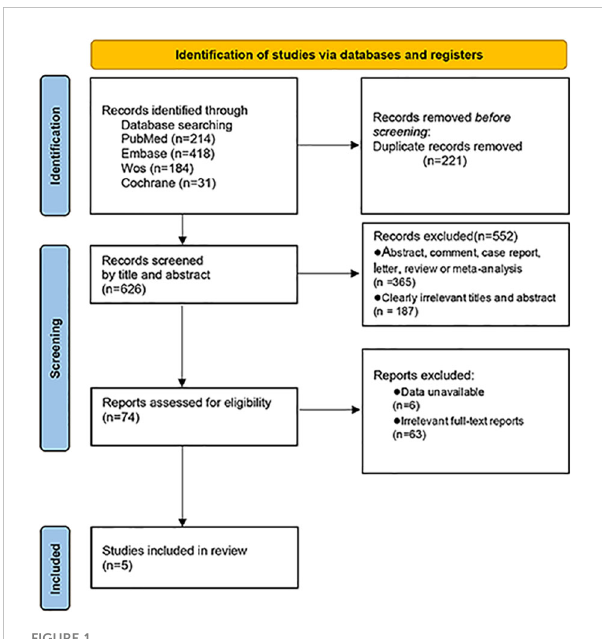
FIGURE 1 Flow diagram for study